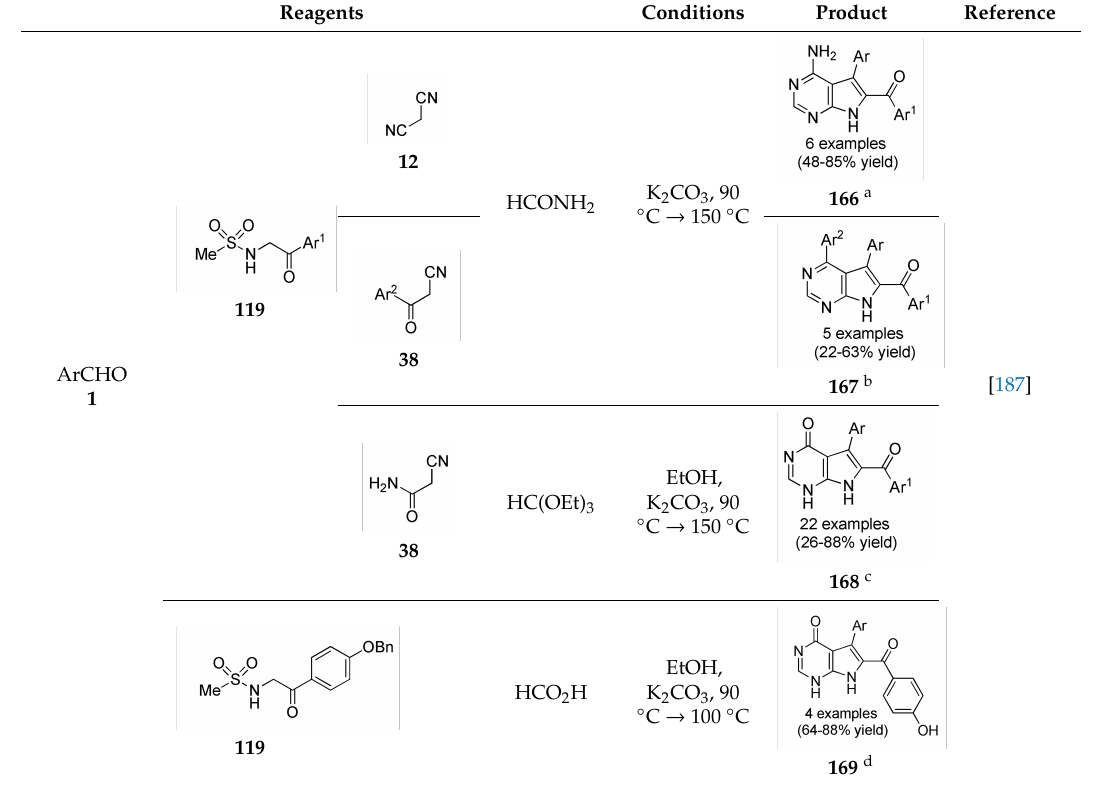
Table 4. Multicomponent approaches for the synthesis of 7-deazaadenine ( 166 ) 7-deazapurine ( 167 ) and 7-deazahypoxanthine skeletons 168 and 169 of potential antitumor